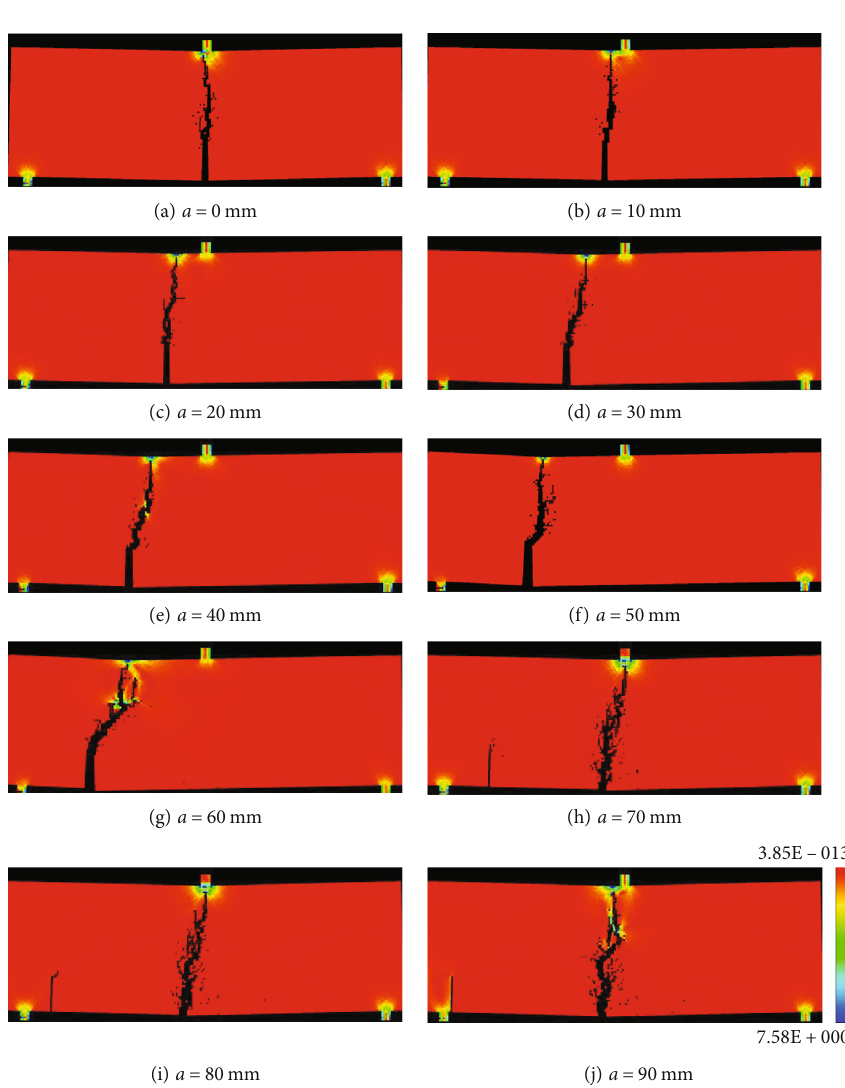
Figure 3: Failure mode of concrete three-point bending beams with di ff erent values of a